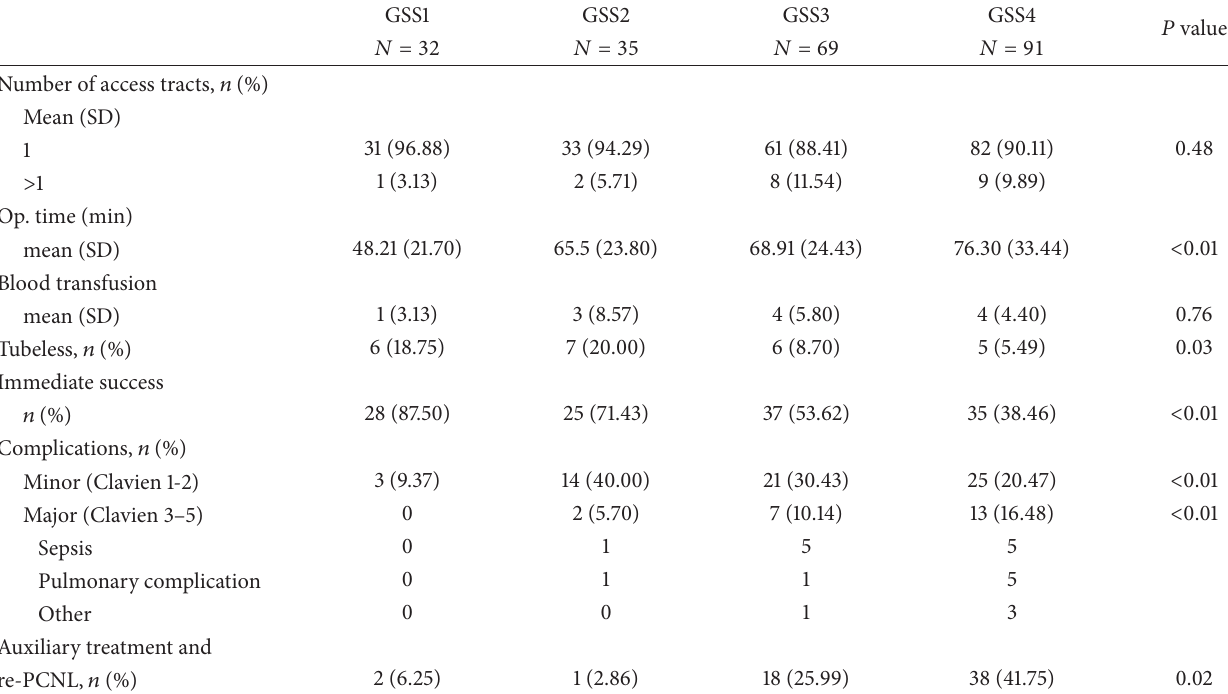
Table 2: Outcomes of total upper pole access operations ( 𝑁 = 227